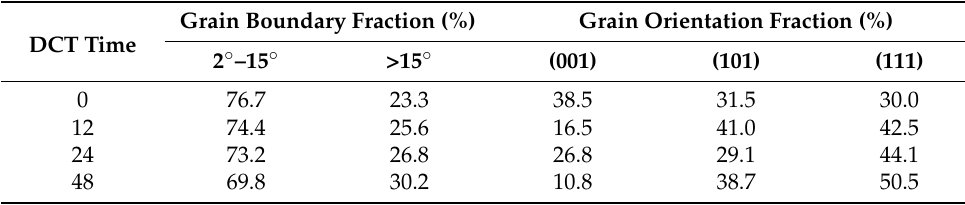
Table 2. The results of the recrystallized fraction and the grain orientation